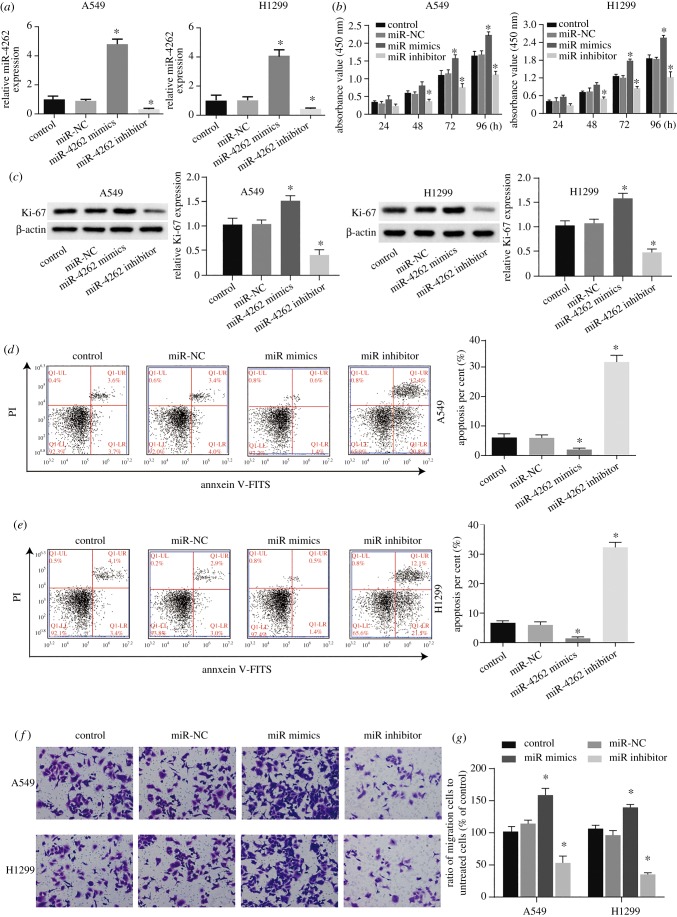
The effect of miR-4262 on cell proliferation, apoptosis and migratory activity in vitro. A549 and H1299 cells were transfected with miR-NC, miR-4262 mimics and miR-4262 inhibitor, and a control group was also investigated. (a) The expression levels of miR-4262 were analysed by qRT-PCR. (b) After 24, 48, 72 and 96 h of transfection, the absorbance (OD450 nm) of the cells was assessed. (c) The proliferation-related protein expression of Ki-67 was detected by western blot. (d,e) Flow cytometry analysis of annexin V and propidium iodide (PI) staining of apoptotic A549 and H1299 cells following transfection for 48 h. The total apoptosis rates (annexin V positive + PI negative + annexin V and PI double-positive cells) were also calculated. (f,g) A Transwell migration assay was conducted to analyse the migratory capacity of A549 and H1299 cells transfected with the miR-4262 mimics or inhibitor at 18 h. The bars represent mean ± S.D; *p < 0.05 versus the miR-NC group.